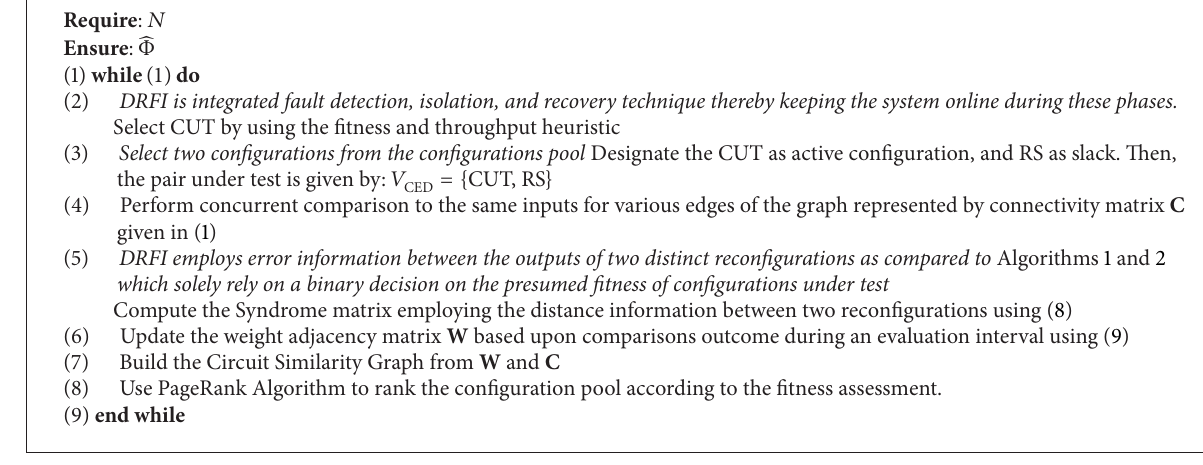
Algorithm 3: DRFI algorithm of ranking the functional